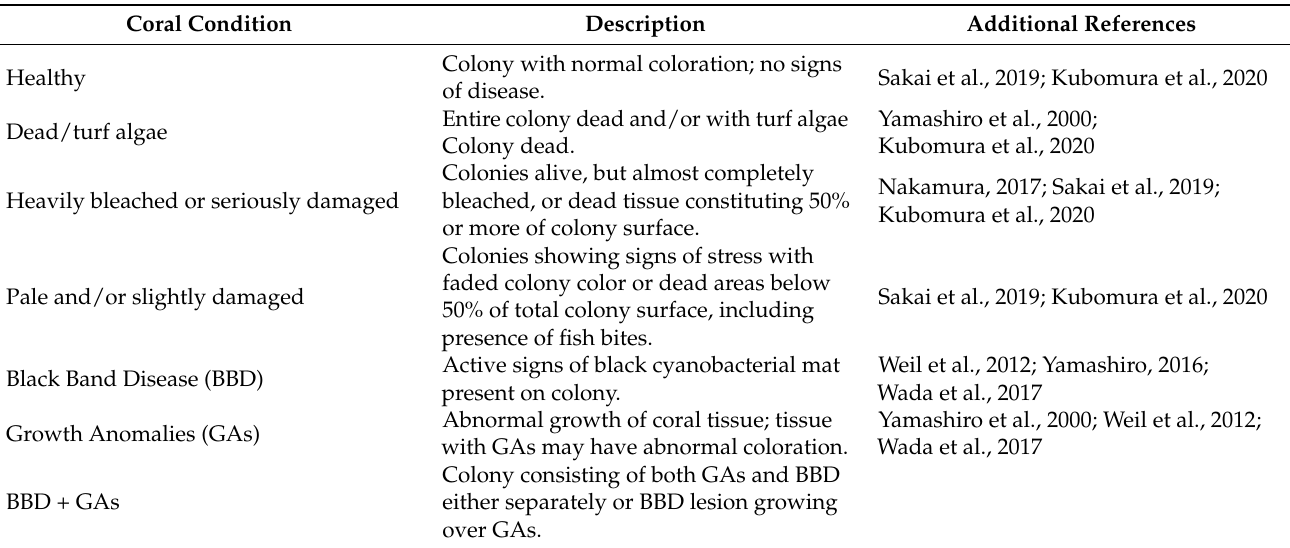
Table 1. Encrusting Montipora assigned